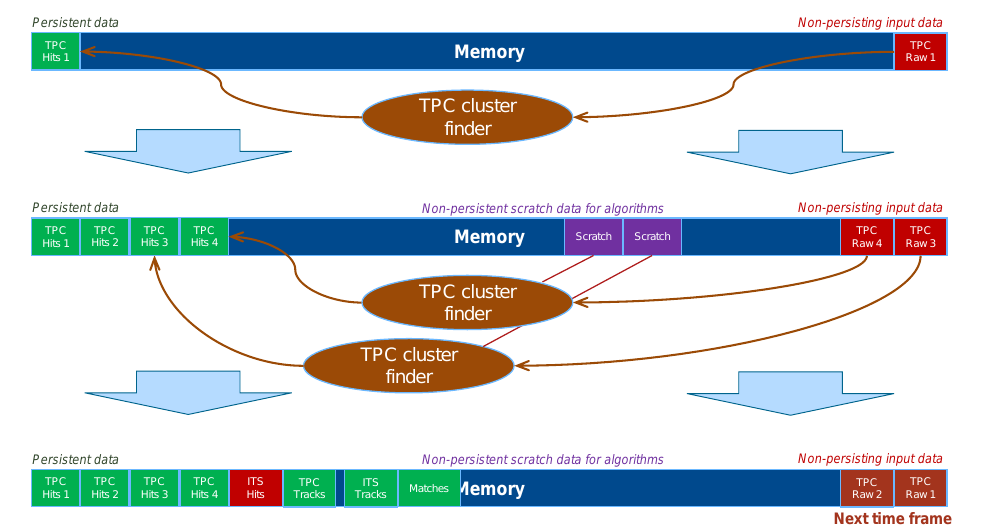
Figure 3. Illustration of the memory allocation strategy during the processing of a time frame.